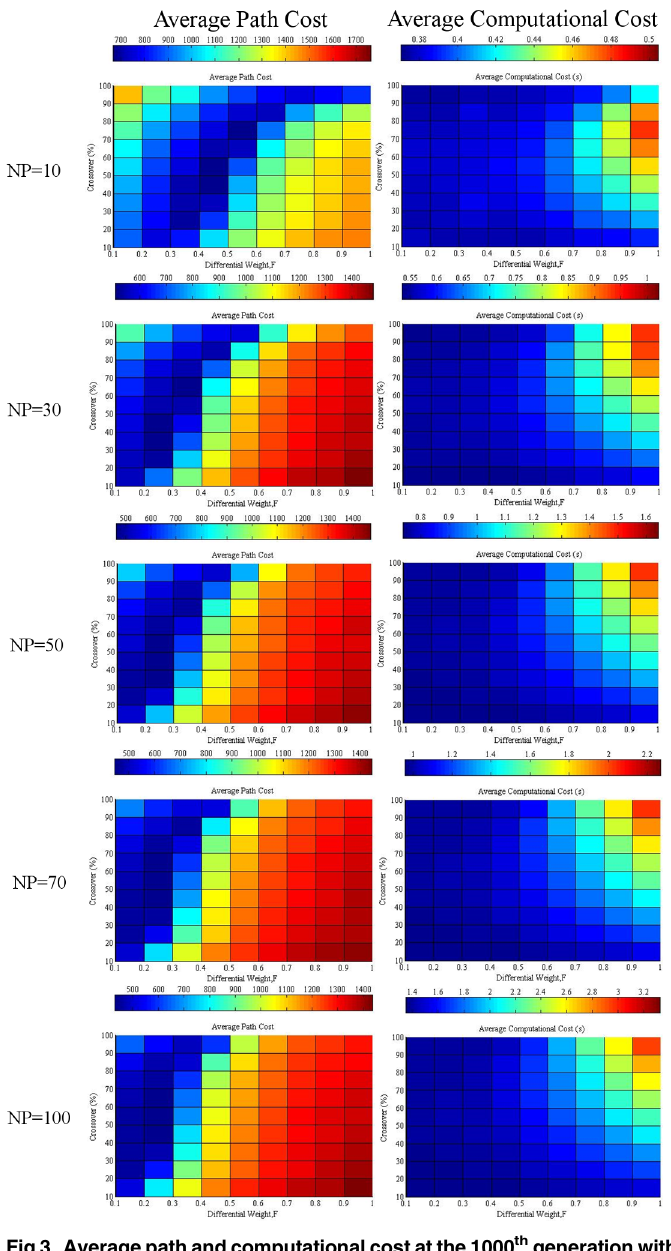
Fig 3. Average path and computational cost at the 1000 th generation with variation between differential weight and crossover at various population sizes of 10, 30, 50, 70, and 100 “ Table A in S1 Dataset.